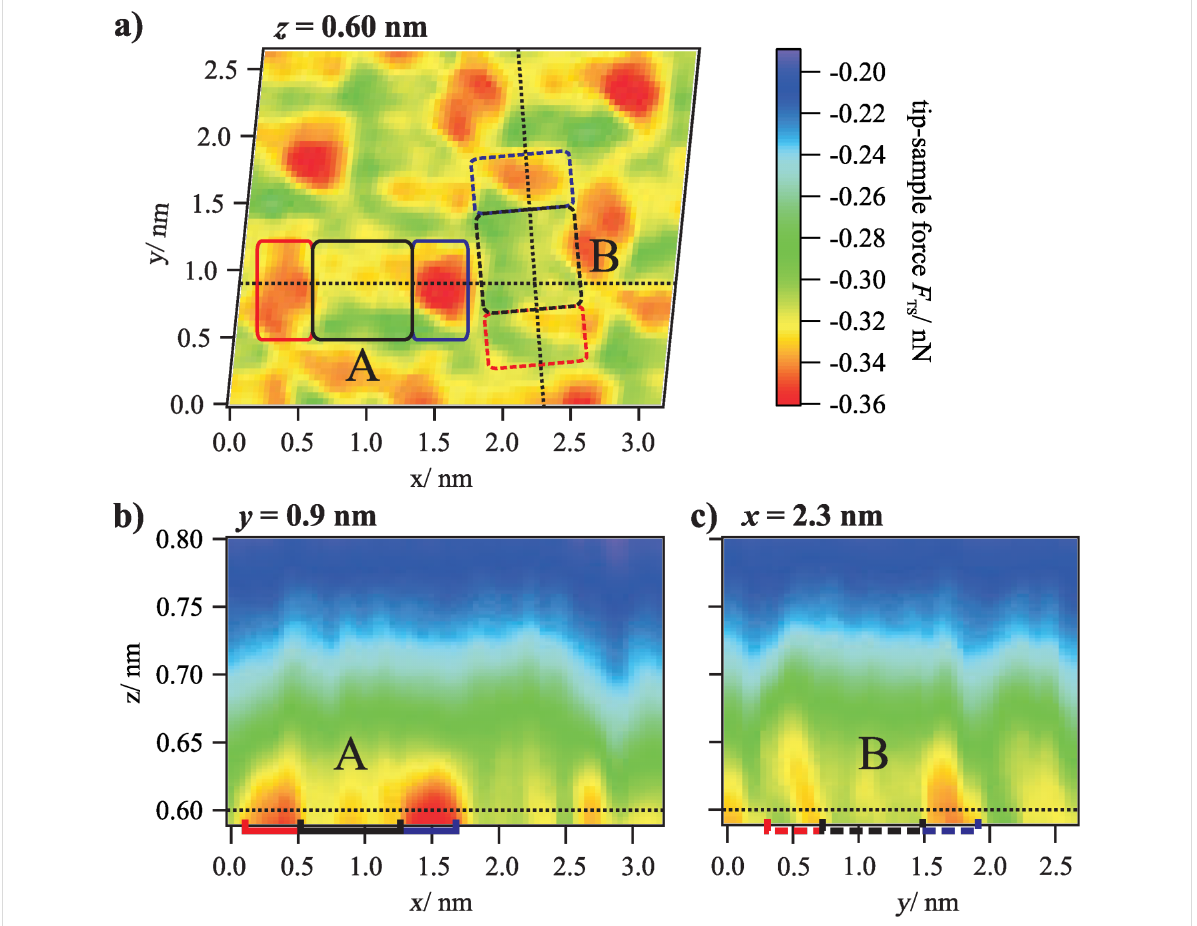
Figure 4: (a) Horizontal cut through the 3D force field at z = 0.60 nm and (b) vertical cuts at y = 0.9 nm and x ≈ 2.3 nm (diagonal progression) along the long axis of two different molecule orientations of the unit cell (the images are linearly interpolated with a factor of 2). For z < 0.65 nm, higher attractive forces are acting on molecule A in comparison to molecule